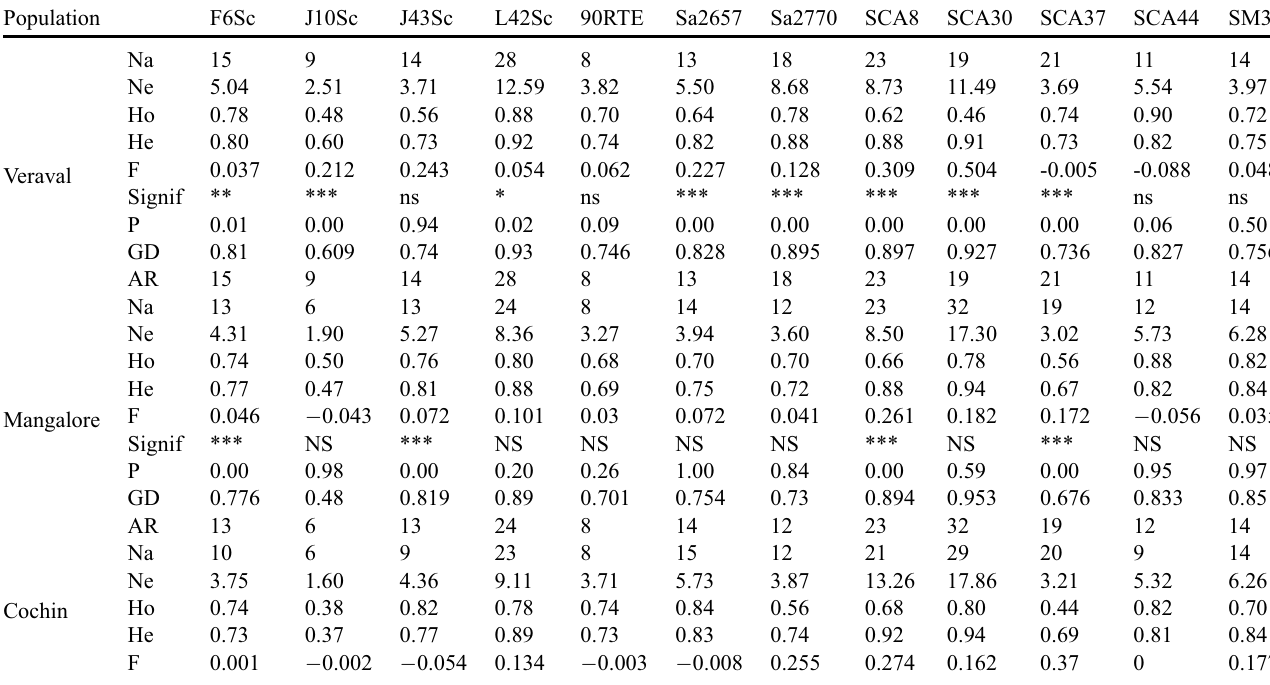
Table A2. Summary statistics of genetic variability parameters of microsatellite